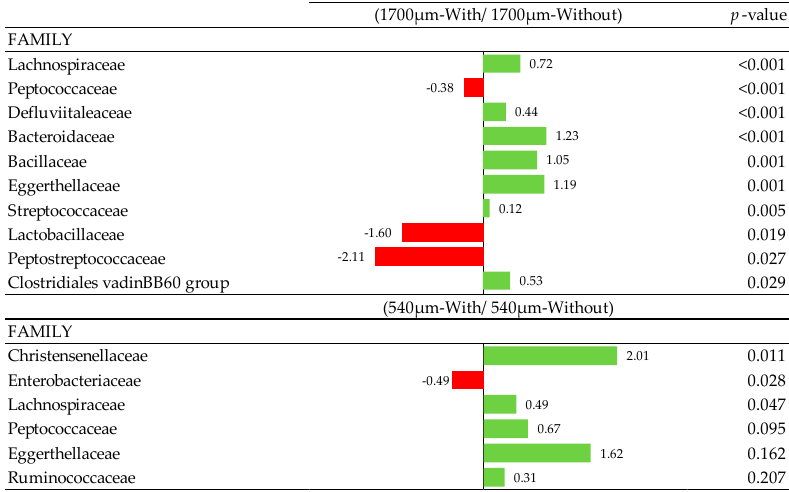
Figure 5. Ln changes promoted by xylanase inclusion in 540 and 1700 µm D gw corn diets (fold discovery rate p- adjusted < 0.20) in taxa. Positive values (  ) and negative values (  ) indicate greater and lower abundance. Taxa are sorted by level of significance (from higher to lower). Differences presented are based on all taxa detected in samples per diet.